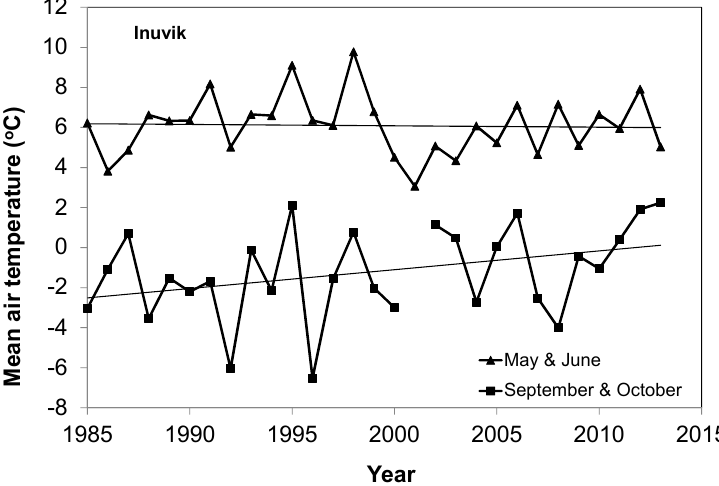
Figure 4. Inter-annual variations and trends in spring (May and June) and fall (September and October) mean temperatures at the Inuvik climate station in low-lying areas near the Ivvavik NP. Statistics for the two trends are listed in Table 3. Table 3. Long term trends in spring (May and June) and fall (September and October) temperature at climate stations near the five study areas during 1985–2013. The trended change is the magnitude of change during 1985 and 2013, calculated as the value of the trend line in 2013—that in 1985.